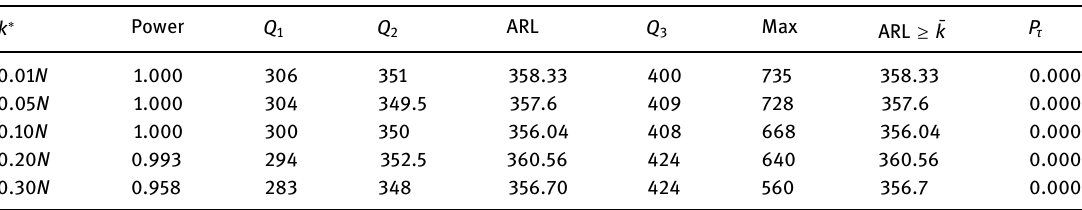
Table 4: Conditional powers, average of run lengths and probability of false alarms for score test with ( ) ≡ g s c under H A